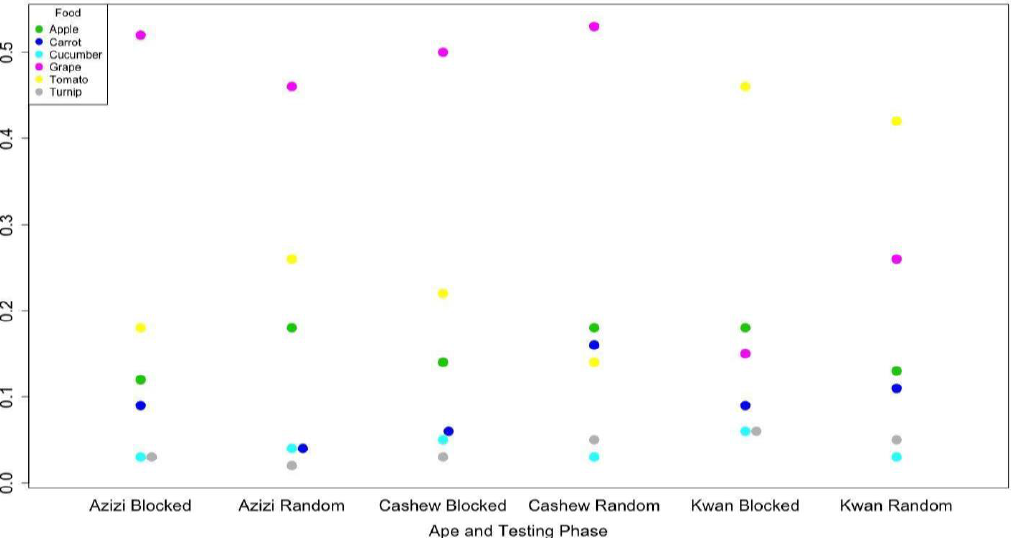
The Three Apes, One Chimpanzee (Cashew) and Two Gorillas (Azizi and Kwan), that Showed Significant Changes in their Food Preferences Across Presentation Style